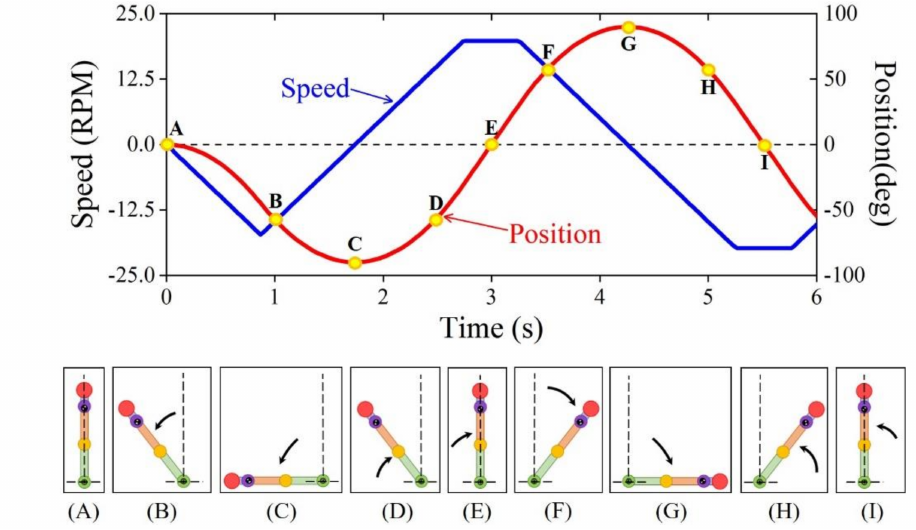
Figure 7. Speed and position profiles of the joint according to the set planar motion